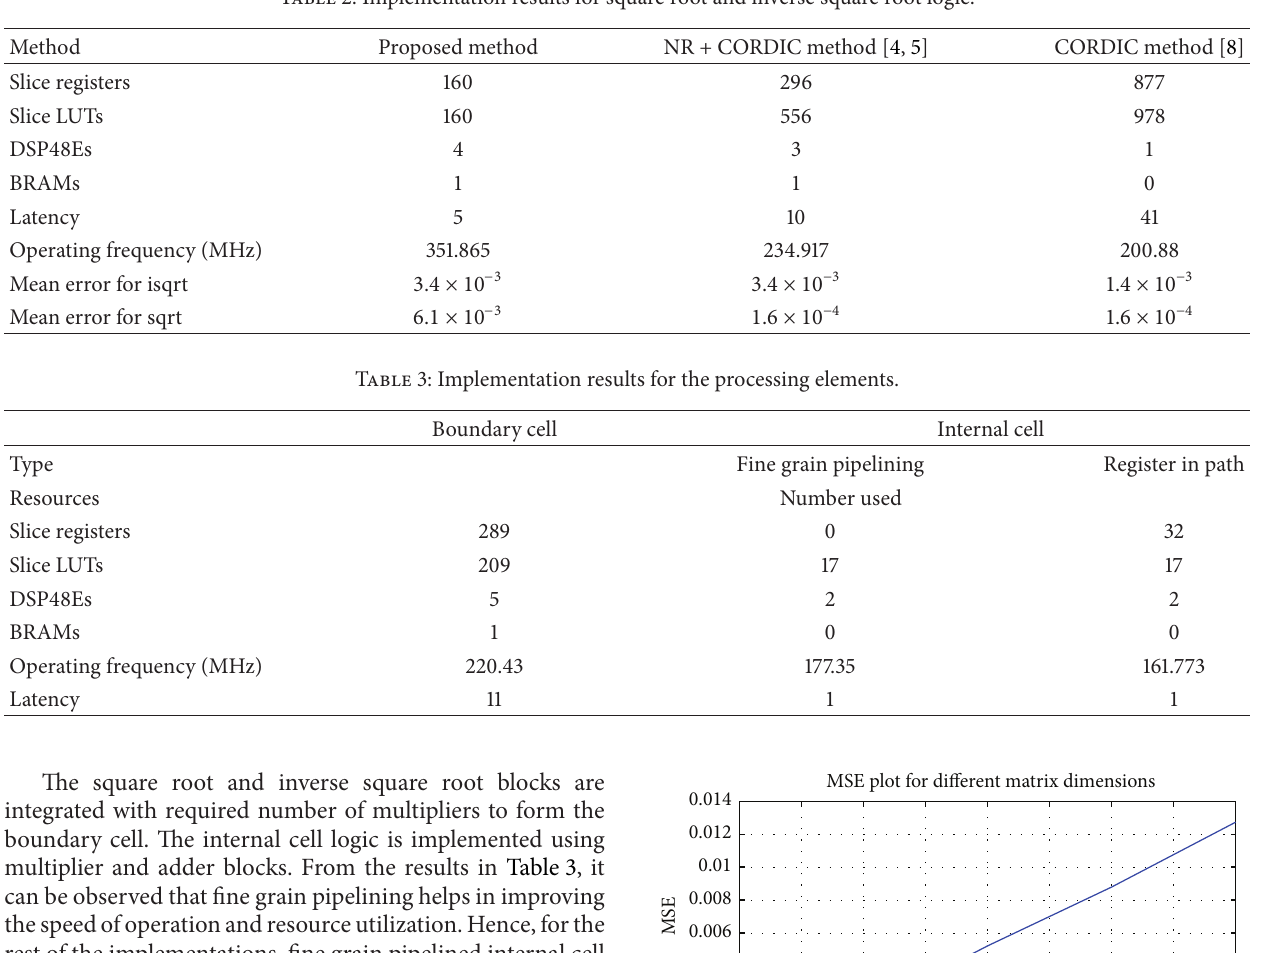
Table 2: Implementation results for square root and inverse square root logic.